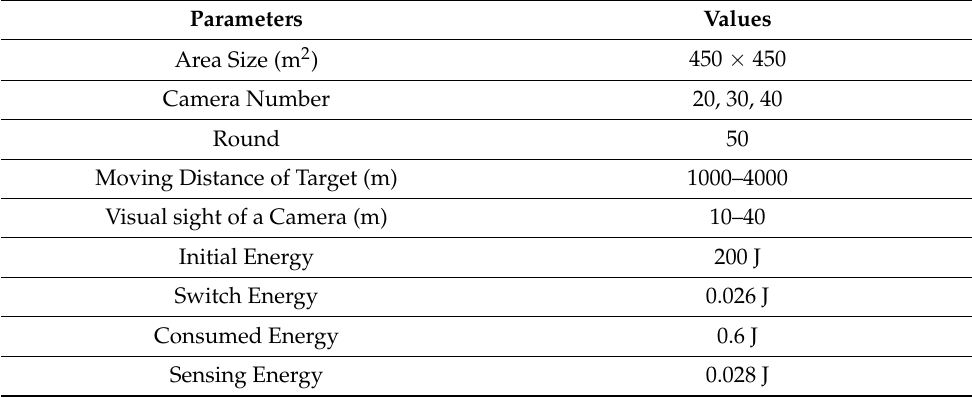
Figure 5. An example of a simulation environment. Table 5. Simulation parameters.